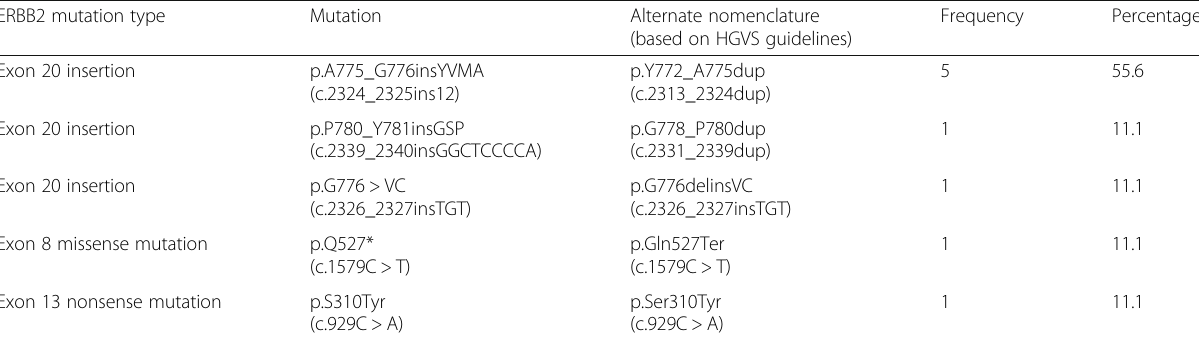
HGVS Human Genome Variation